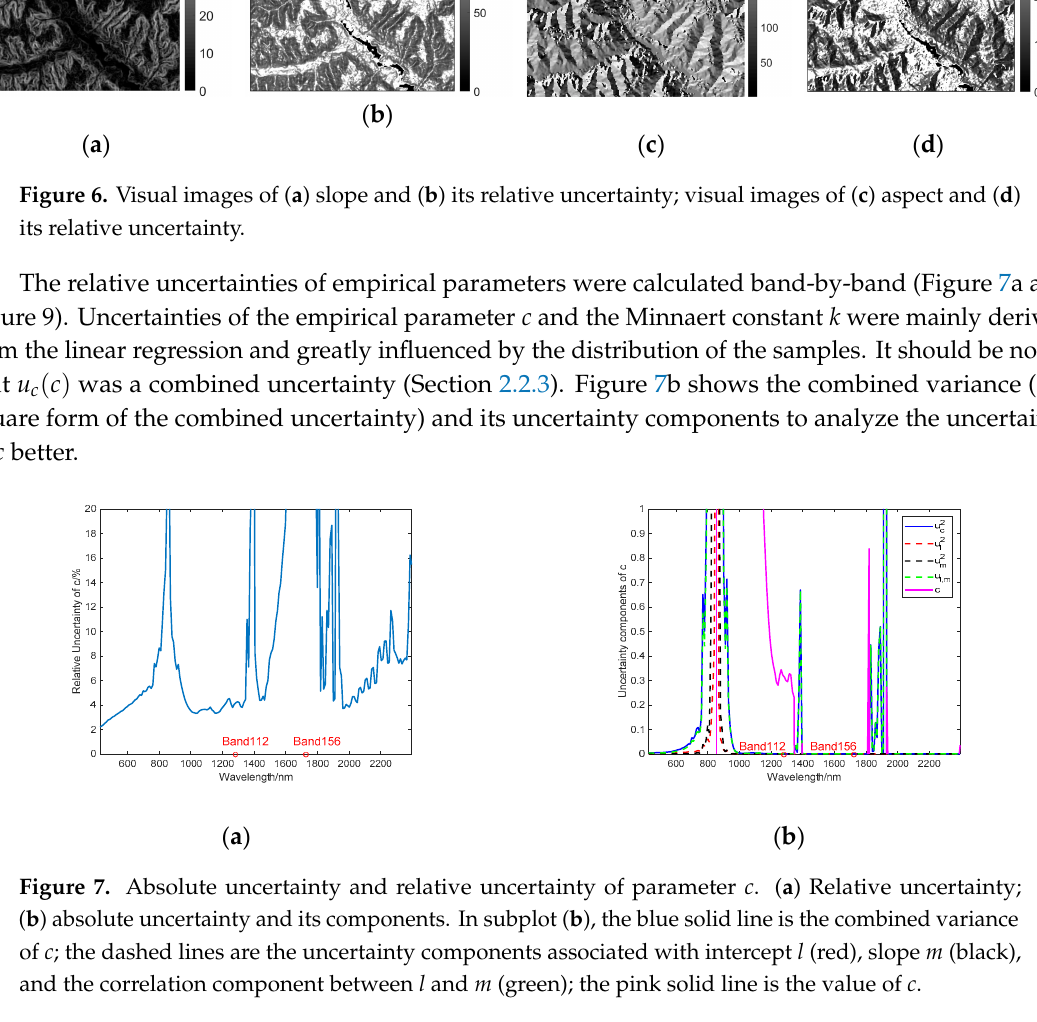
Figure 6. Visual images of ( a ) slope and ( b ) its relative uncertainty; visual images of ( c ) aspect and ( d ) its relative uncertainty.